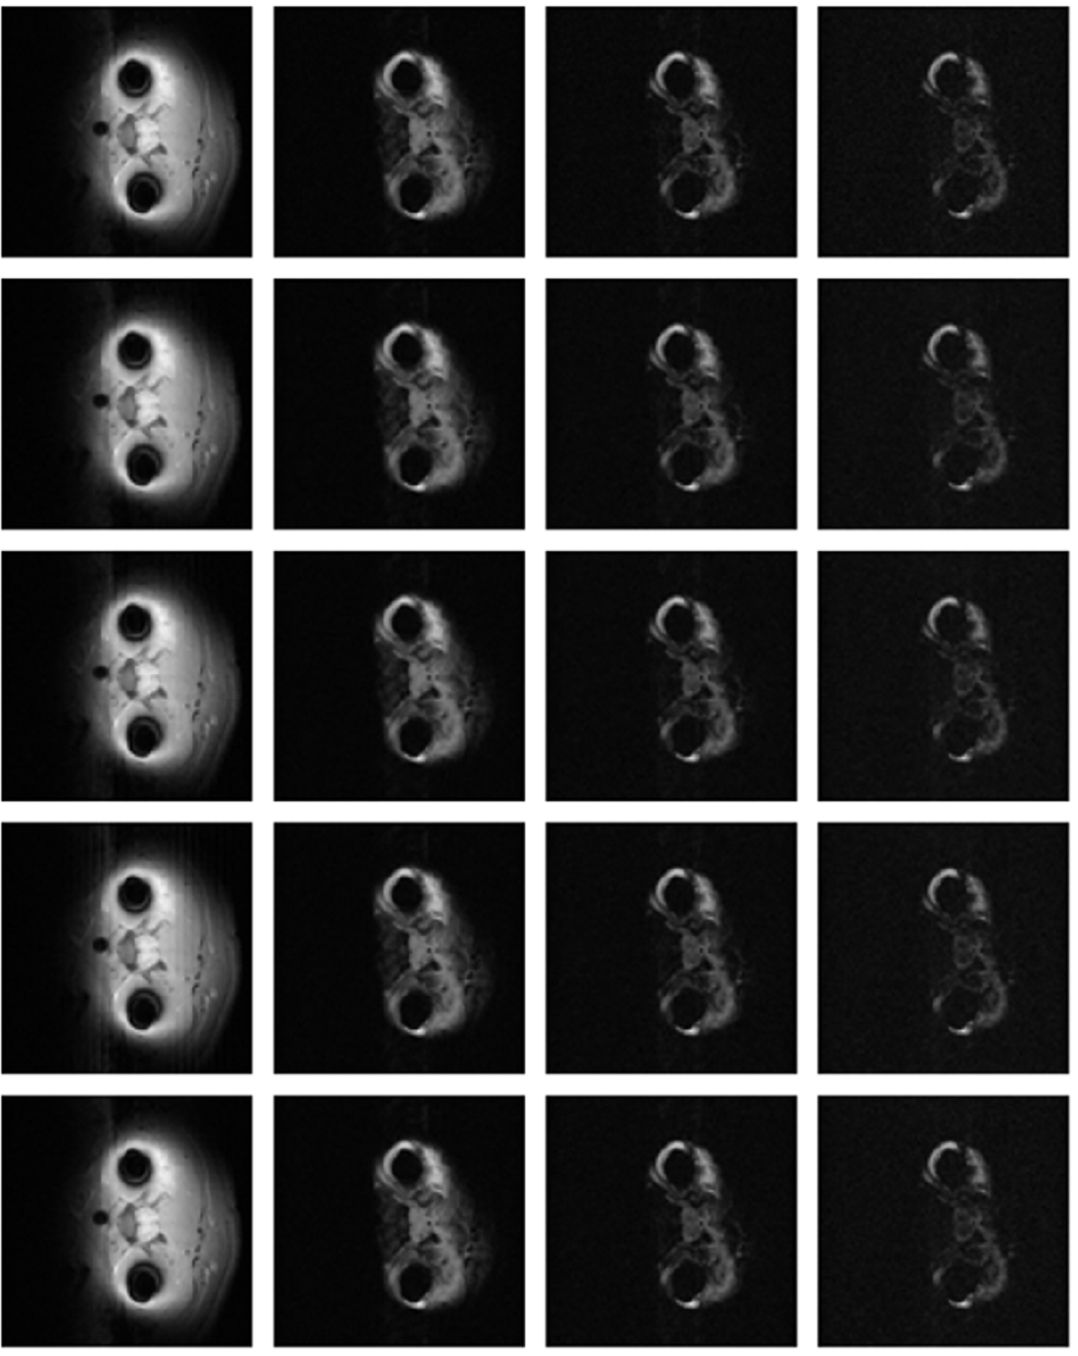
Figure 4. Images from in vivo reconstruction. Top row—groundtruth; 2nd row—same sampling pattern, row-sparse recovery; 3rd row—same sampling pattern, rank-deficient row-sparse recovery; 4th row—different sampling pattern, group-sparse